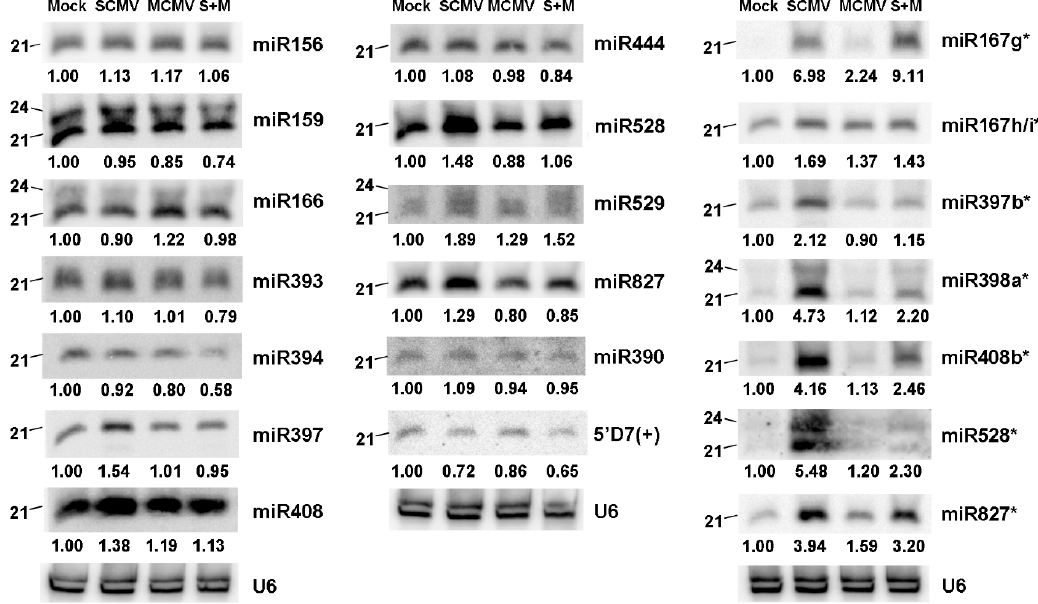
Figure 3. The accumulation of small RNAs in Mock-, SCMV-, MCMV-, and S + M-inoculated maize plants. The accumulation of small RNAs was detected at 9 dpi by Northern blotting. The samples from three independent experiments with at least three biological replicates each were pooled for RNA extraction. U6 was used as a loading control. The expression levels of small RNAs from Mock-inoculated plants (negative controls) were set to a value of 1.00 as reference, and these from SCMV-, MCMV-, or S + M-inoculated maize plants were counted relative to the levels of Mock-inoculated maize plants from the same experiments using the Image J software.